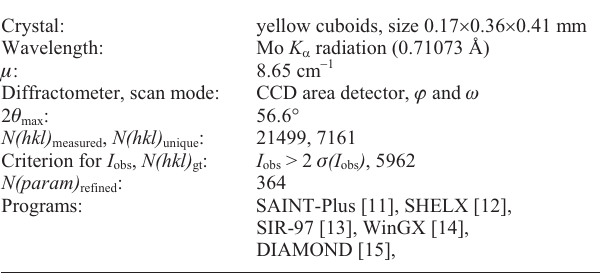
Table 1. Data collection and